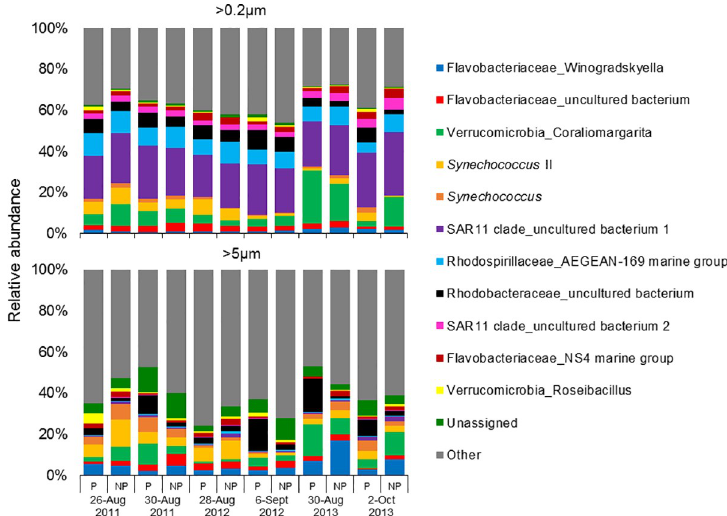
Fig 6. Genus- level relative abundances of bacterial sequences from size fractionated ( > 0.2 and > 5 micron) samples collected within and immediately adjacent ( < 10m) to the Cochlodinium bloom patches, designated ‘patch’ (P) and ‘non-patch’ (NP) samples, respectively, for years 2011, 2012 and